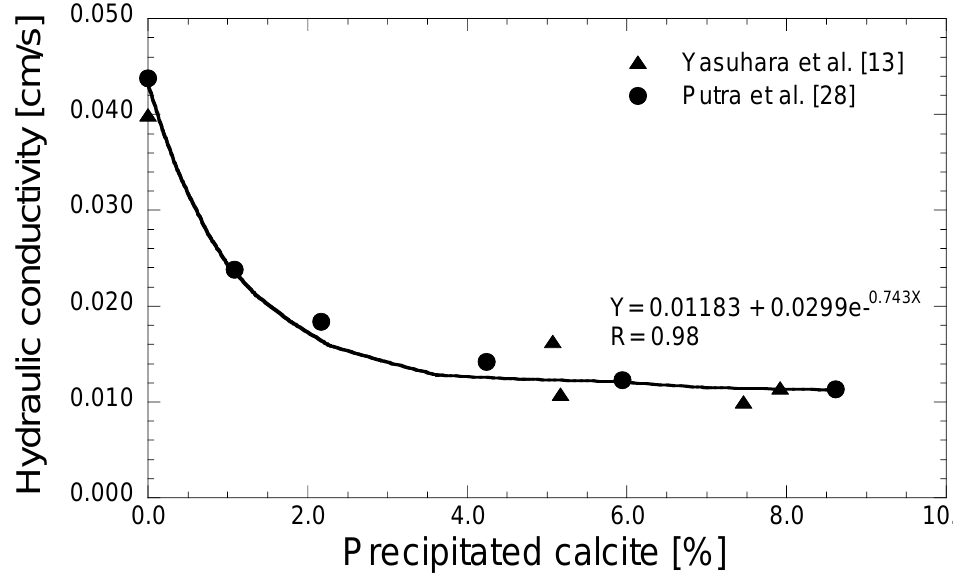
Figure 6. Permeability test results of cemented sand after treatment by EICP grouting solution [13,28].